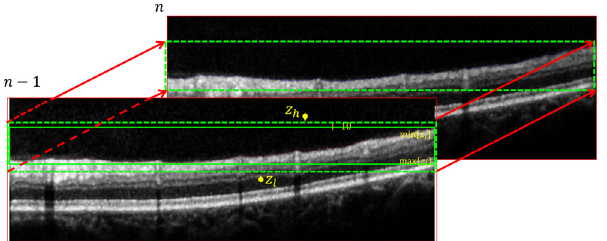
Fig 4. Illustration of the search region refinement using the inter-frame dependency approach. Taking into account that the ILM boundary is delineated in the frame n − 1, the search region of C 1 n could be limited to be min fð z i g (cid:2) 10 ; max f z i g þ 10 (cid:5) ; 8ð x ; z i Þ 2 C 1 n (cid:2) 1